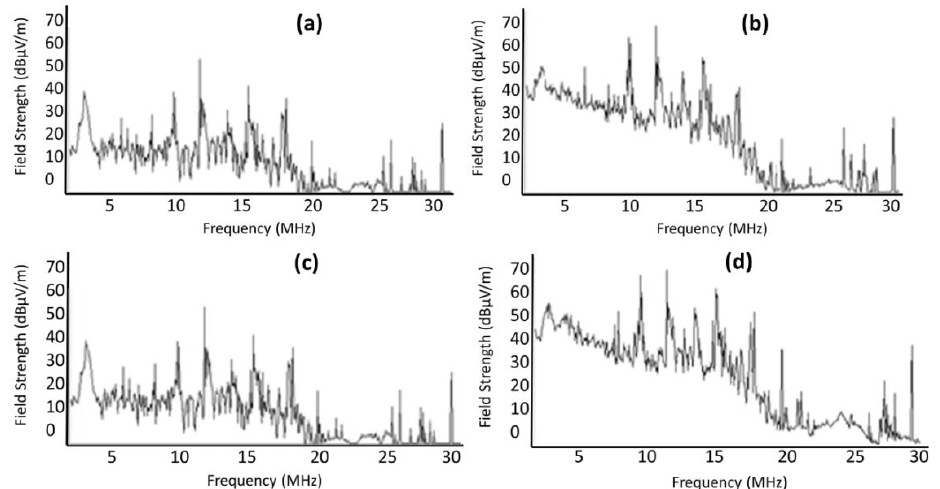
Figure 17. ( a ) 2-30 MHz R&S high angle, ( b ) 2-30 MHz array East-West, ( c ) 2-30 MHz R&S high angle, and ( d ) 2-30 MHz array North-South.